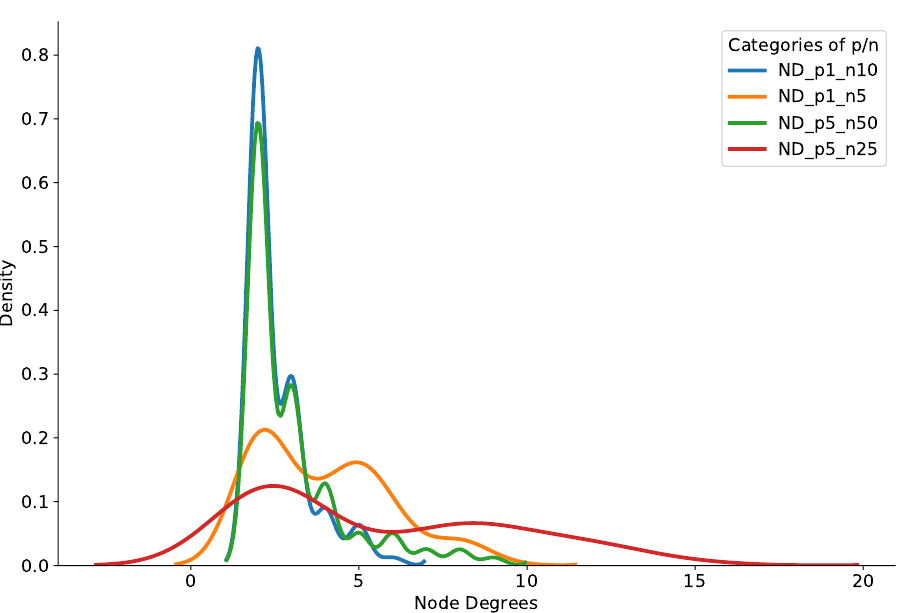
Figure 8. Density of brokers’ node degrees with multi-modal topic subscriptions.